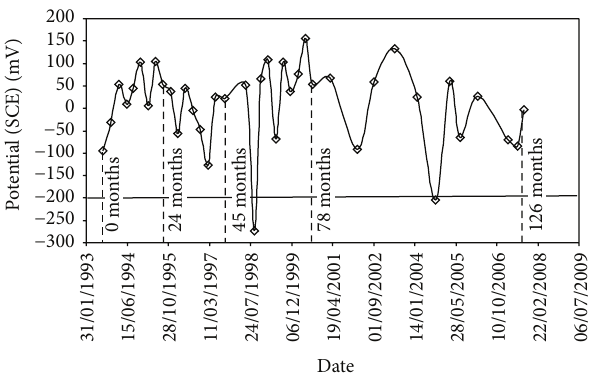
Figure 3: Test cylinder section profile. Samples were taken at dif- ferent depths for SEM and EDX analyses.